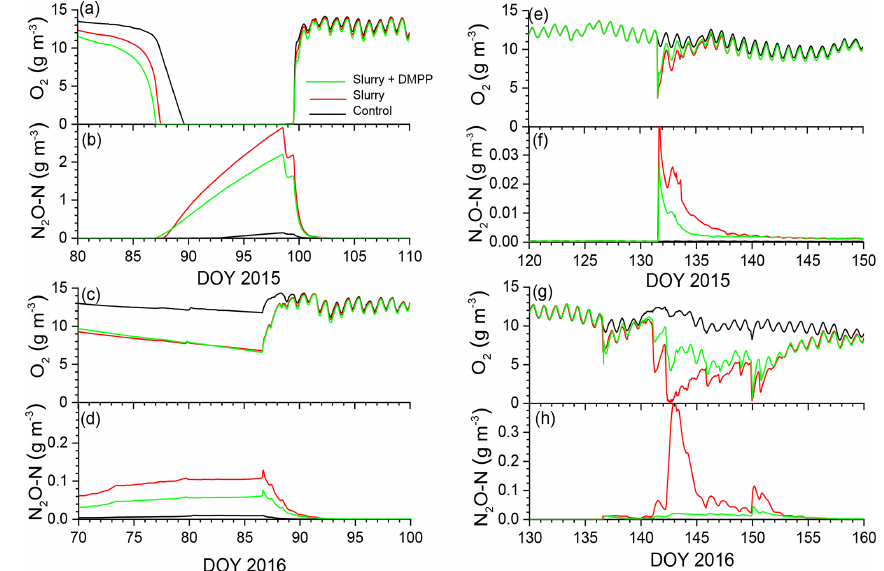
Figure 3. Aqueous concentrations of O 2 and N 2 O modelled at depth of slurry injection (14cm) during emission events in early spring of (a, b) 2015 and (c, d) 2016 after fall slurry applications with or without DMPP on DOY 273 in 2014 and DOY 280 in 2015 and later in spring of (e, f) 2015 and (g, h) 2016 after spring slurry applications on DOY 132 in 2015 and DOY 137 in